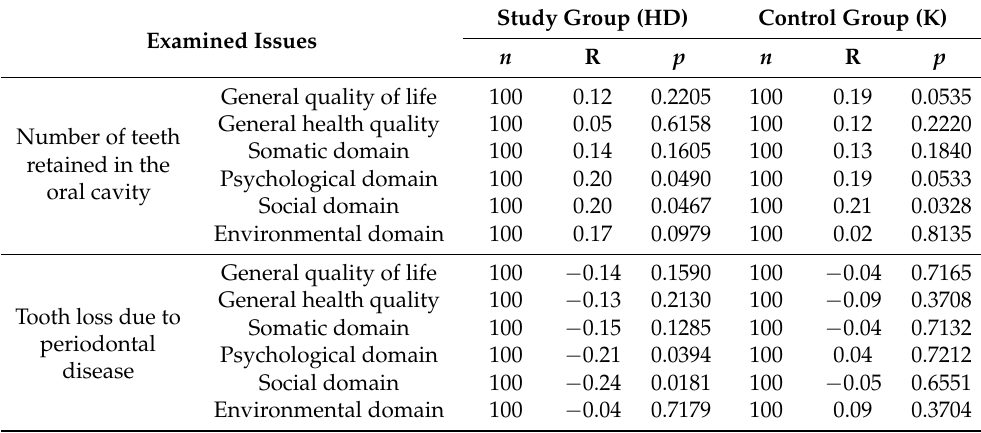
Table 7. Quality of life vs. number of teeth retained in the oral cavity, tooth loss due to periodontal disease in the study groups (HD, K).